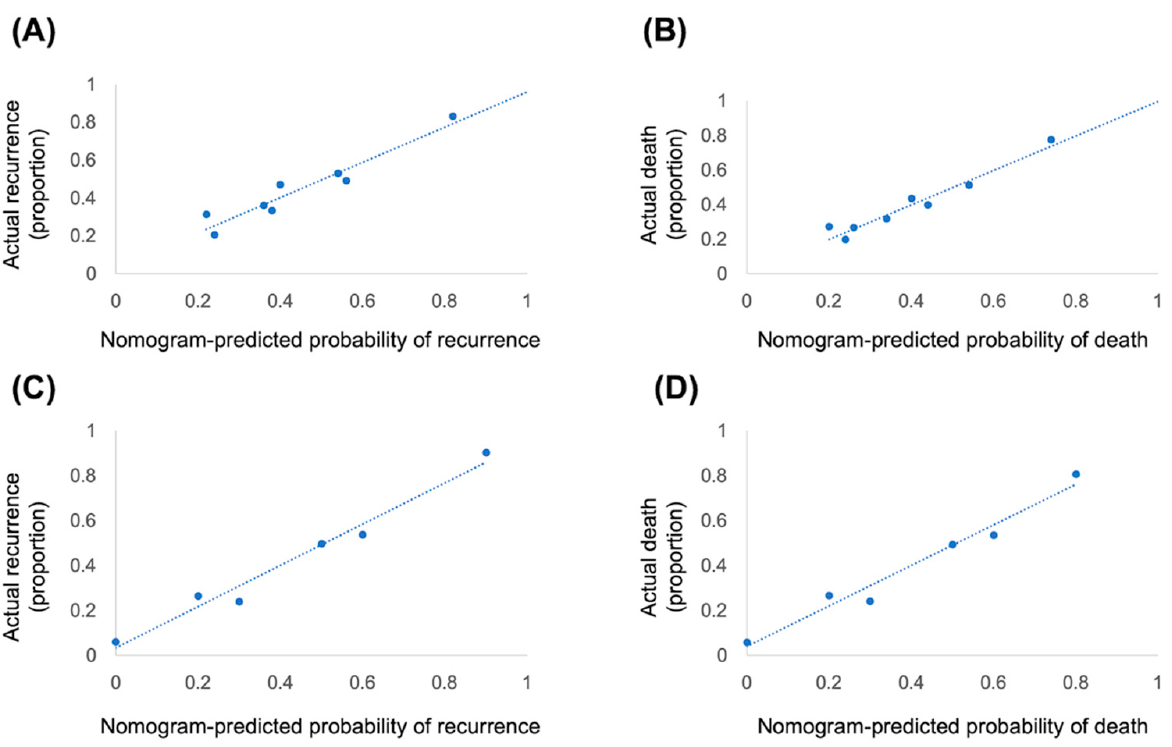
Figure 5. Calibration plots show the relationship between the predicted probabilities based on the nomogram and actual values of the training cohort ( A , B ) and validation cohort ( C , D ).